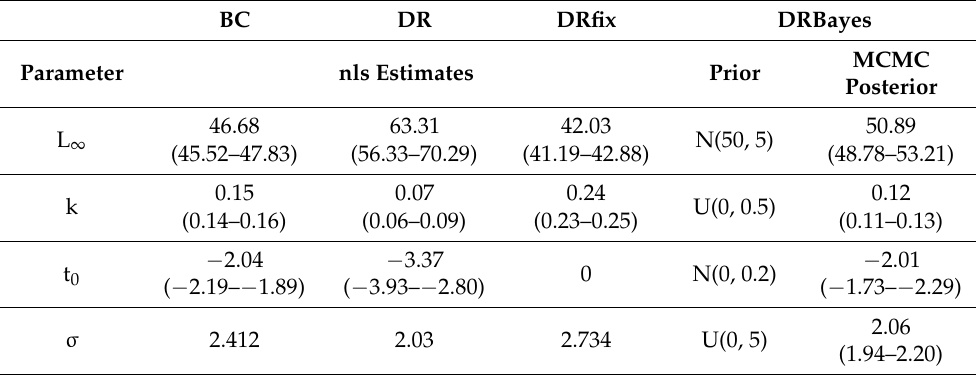
Table 4. Von Bertalanffy growth parameters’ estimates for Trachurus picturatus from Portuguese continental coast derived from different data sets and approaches. 95% confidence intervals are given in parentheses. For Bayesian inference the prior probability distributions used is given with mean and standard deviation, posterior probability distributions are reported as the mean, with lower and upper limits of the 95% credible interval in parentheses. BC—back-calculation; DR—direct readings; DRfix—direct readings with t 0 = 0; DRBayes—direct readings with Bayesian Inference; MCMC—Markov chain Monte